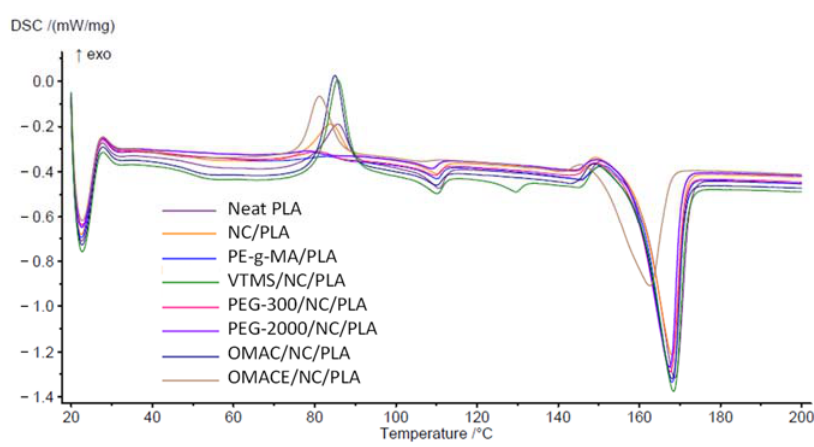
Figure 5. The DSC cooling curve.